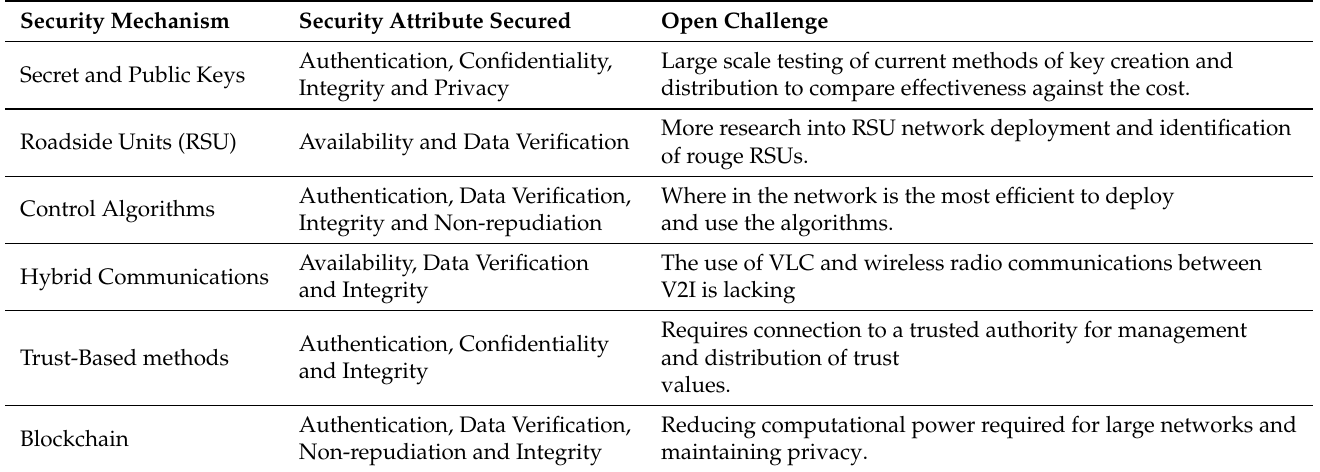
Table 4. Vehicular Platoon defence methods identified from the